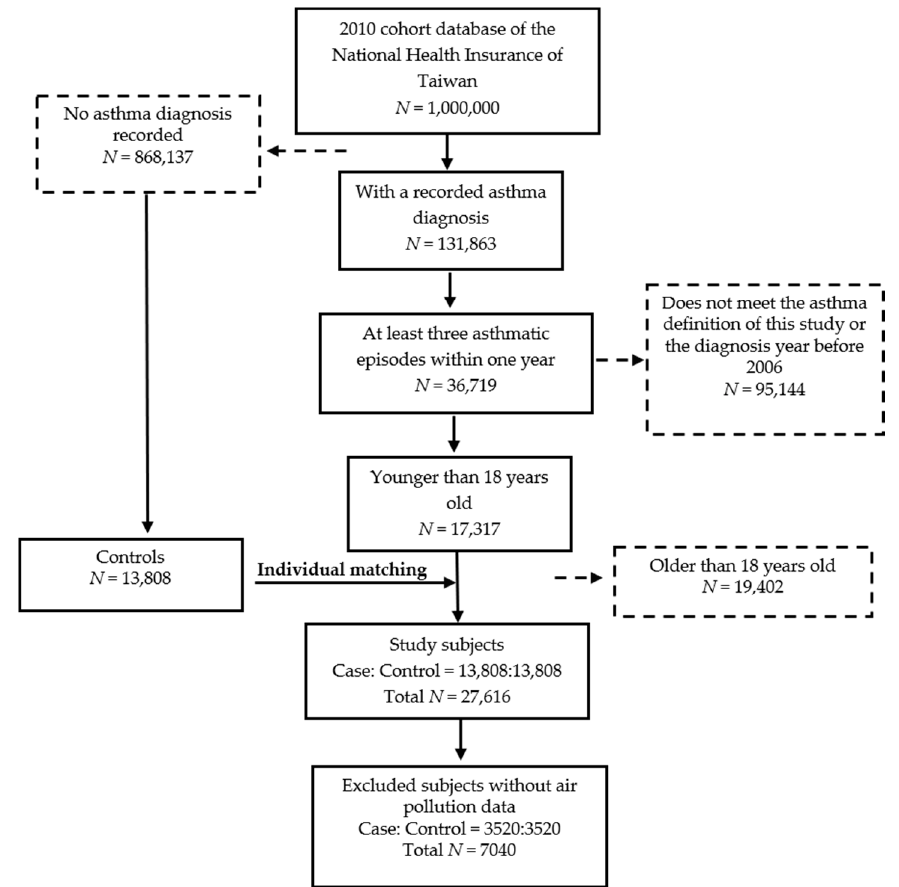
Figure 1. A flowchart of participant inclusion in this study.